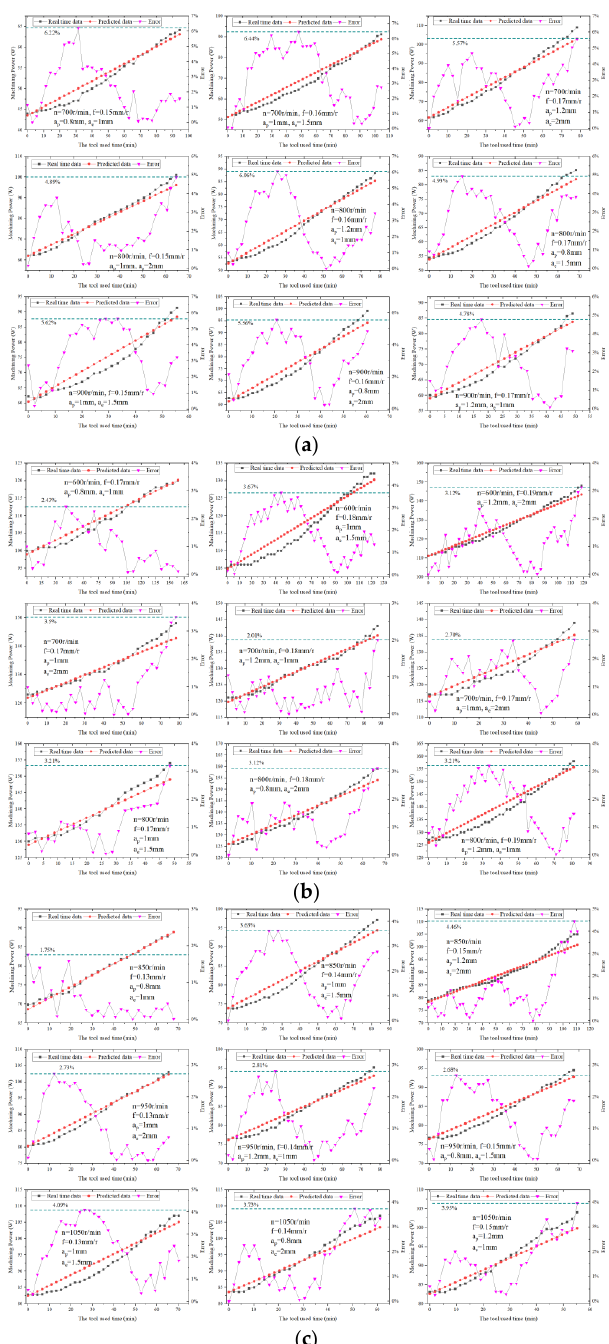
Figure 20. Comparison of machining power and tool utilization time data: ( a ) 𝑀 1 , 𝑀 2 ; ( b ) 𝑀 3 , 𝑀 4 ; ( c ) 𝑀 5 , 𝑀 6 .